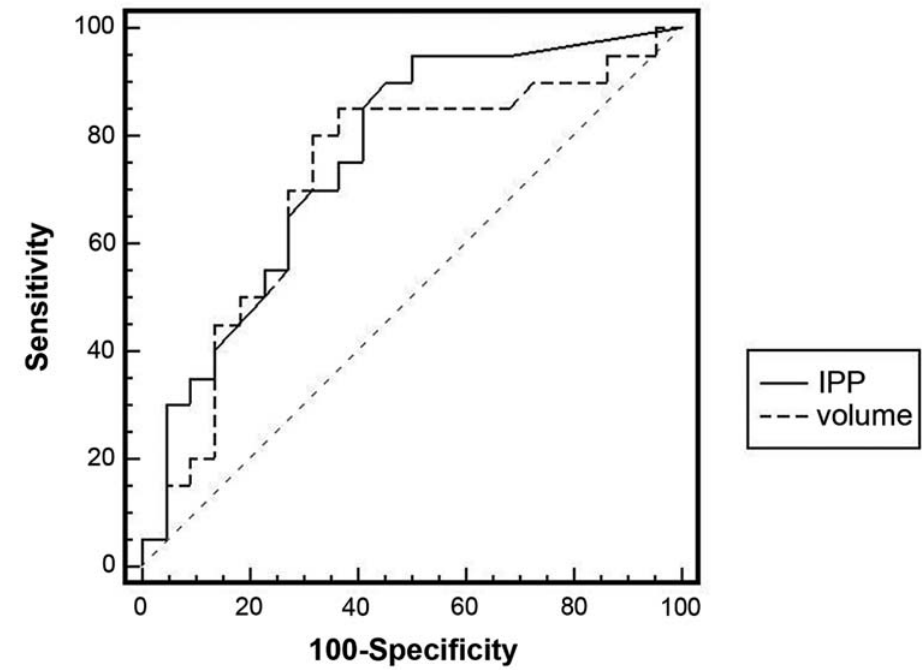
Figure 2 – Receiver Operating Characteristic (ROC) curve for intravesical prostatic protrusion (IPP) and prostate